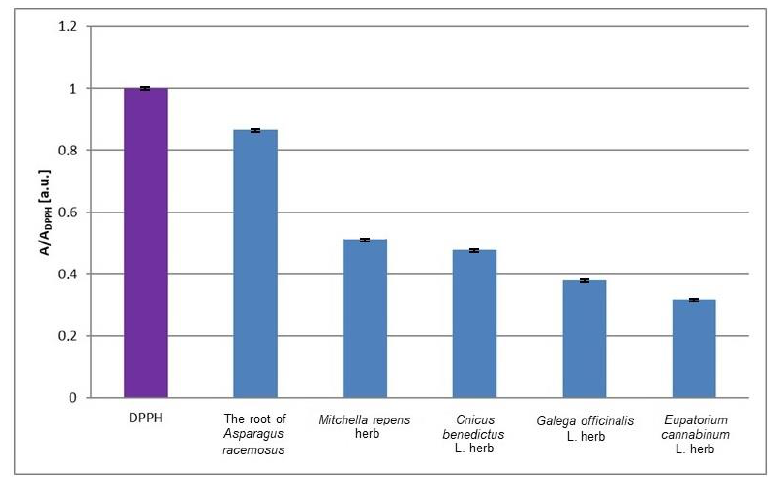
Figure 3. Comparison of the relative amplitudes (A/A DPPH ) [±0.02 a. u.] of the EPR spectra of DPPH free radicals interacting with infusions of the root of Asparagus racemosus , Mitchella repens herb, Cnicus benedictus L. herb, Galega officinalis L. herb, and Eupatorium cannabinum L. herb for 33 min. A—amplitude of the EPR line of DPPH free radicals in contact with the tested infusion. A DPPH —amplitude of the EPR line of DPPH free radicals in the reference solution. For the reference solution, the relative amplitude (A/A DPPH ) takes a value of 1. Data for the infusions obtained from the plant materials not exposed to UV radiation.